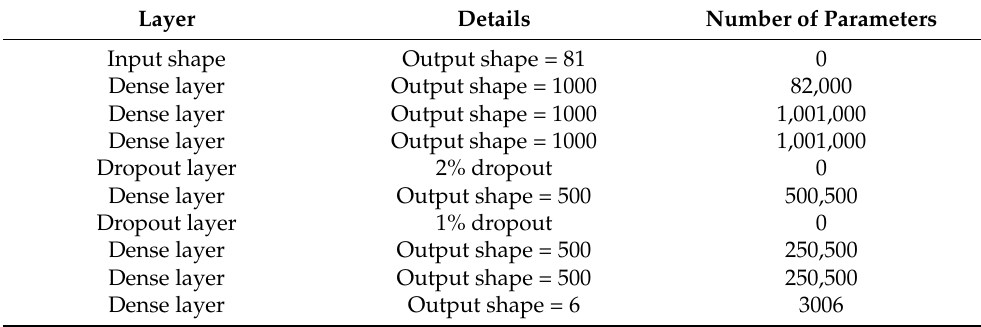
Table 4. Summary of final IDNN model architecture.